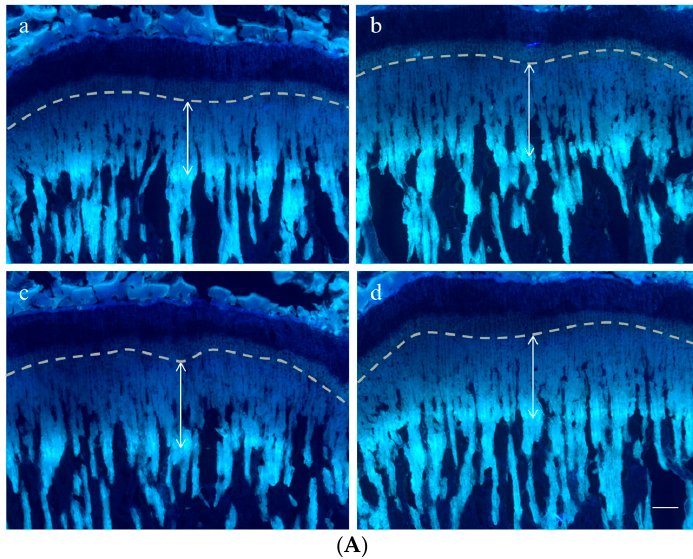
Figure 2. Cont . Figure 2. Cont